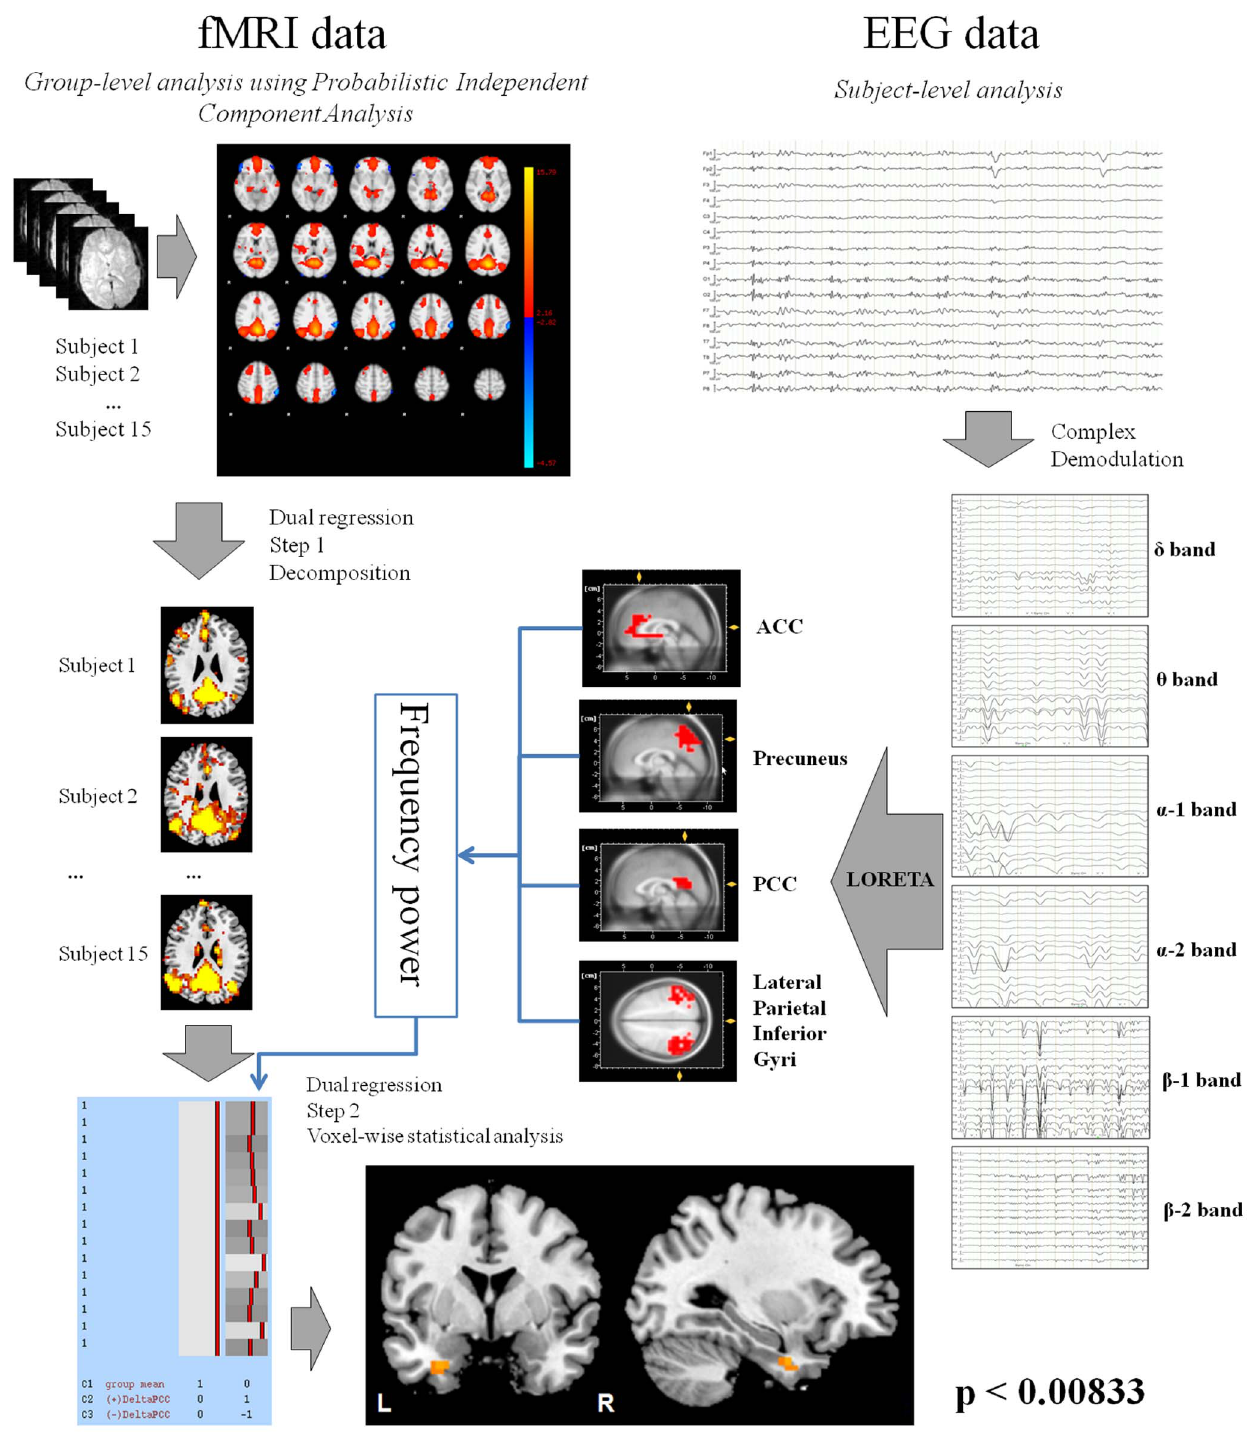
Figure 1. Methodological approach: LORETA analysis was performed after correction and demodulation for a specific frequency. The extracted average power was included into the dual regression analysis in order to identify brain structures whose BOLD signal variation correlates with the power of EEG-frequencies. The image below shows voxels in which alpha power extracted from the ACC was positively correlated (p , 0.00833) with the activity of the DMN. Furthermore a positive correlation between the beta-1 frequency beta-2 frequency power extracted from the PCC and the power extracted from the PCC and the connectivity values of the precuneus showed a positive correlation with DMN connectivity right supplementary motor cortex was established. In addition, the to right frontal cortex. Furthermore, we verified that such